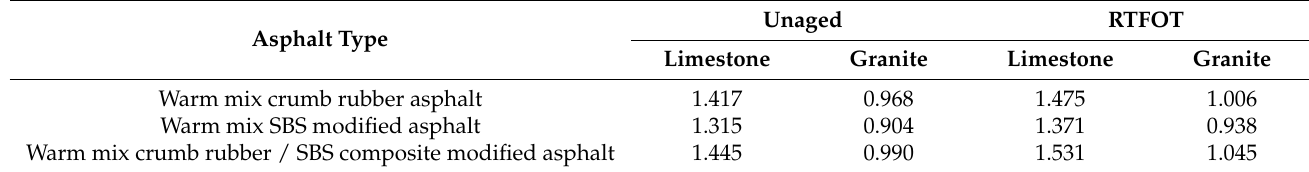
Table 10. Energy ratio of asphalt and aggregate before and after